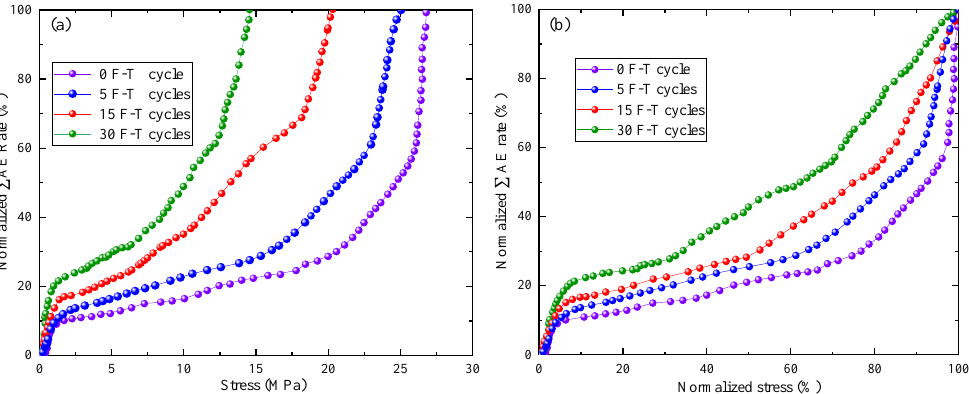
Figure 17. Changes in the acoustic behavior and stress with different F-T cycles. ( a ) Stress; ( b ) Normalized stress.